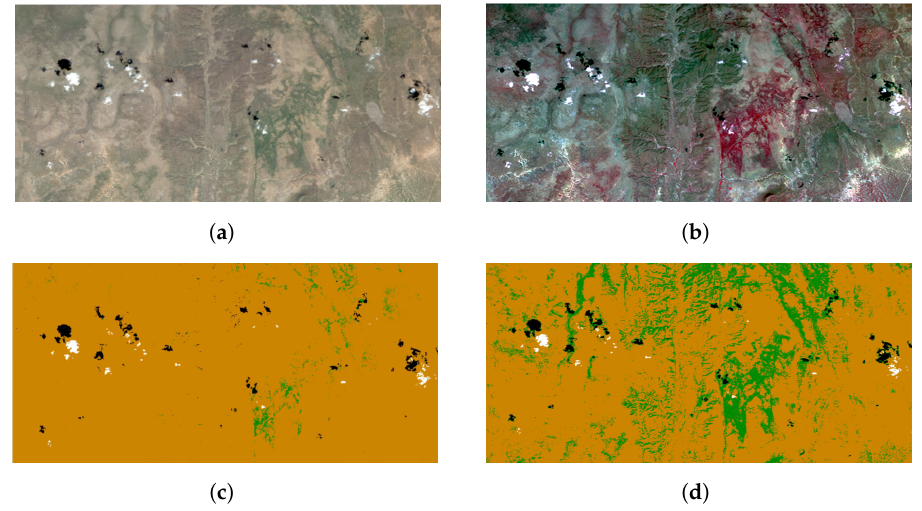
Figure 8. Comparison of segmentation maps obtained with only the 10 m GSD bands and with a combination of 10 m and SR 20 m bands. ( a ) True Color 10 m GSD (RGB); ( b ) False color 20 m GSD {B7,B6,B5}; ( c ) Segmentation using only 10 m bands; ( d ) Segmentation using 10 m and 20